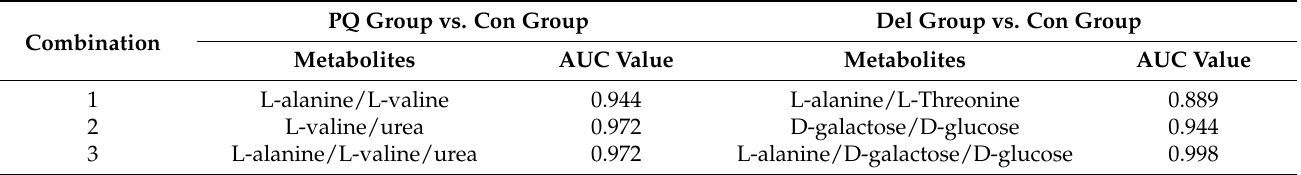
Table 2. List of the screened biomarker